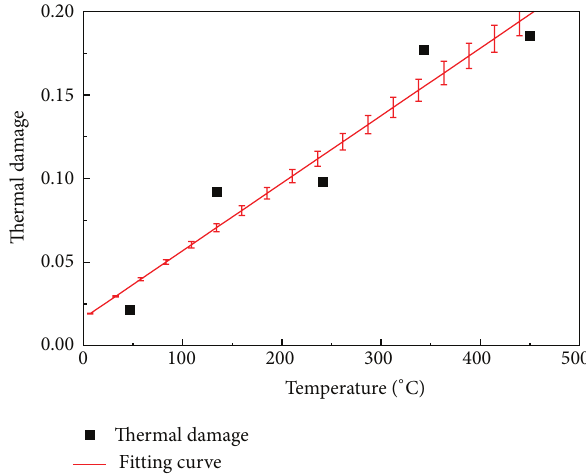
Figure 6: Thermal damage curve under different temperatures in granite.